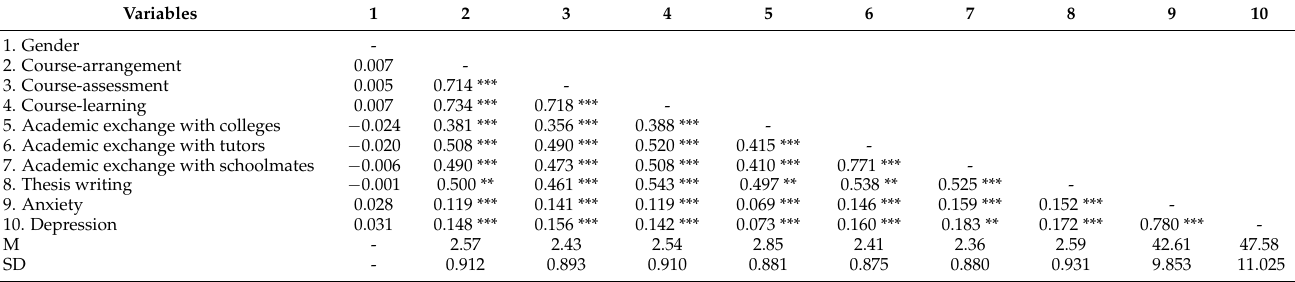
Table 2. Means, standard deviations, and correlations among study